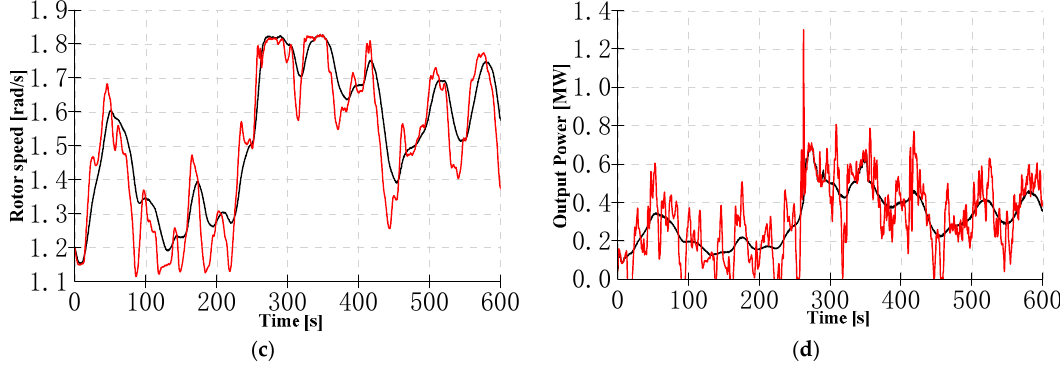
Figure 5. Simulation results under Case 1 with mean speed of 6 m/s and TI of 0.236.